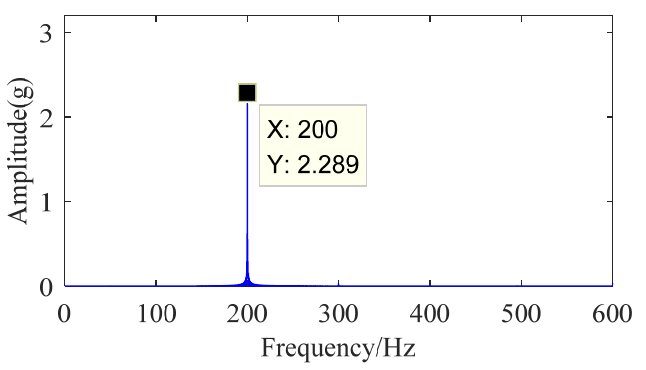
Figure 17. Vibration response of 304 stainless steel clamp with a 200- µ m-thick hard coating of 8% Y 2 O 3 -Z r O 2 under 200 Hz fixed-frequency excitation.